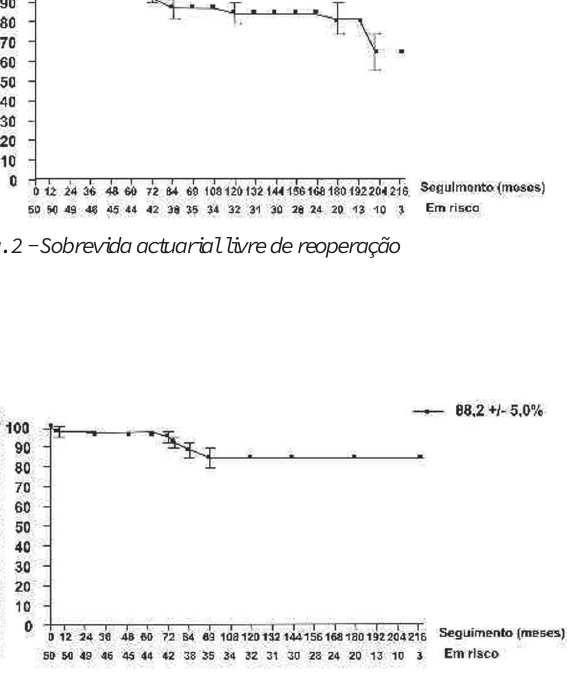
Fig. 3 - Sobrevida actuarial livre de